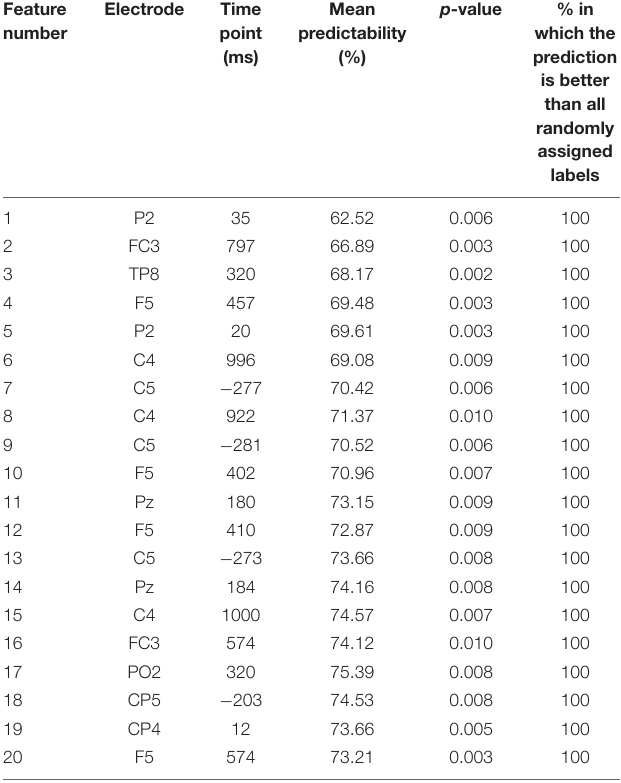
TABLE 1 | Summary of the extracted features showing feature number, electrode site, time point in ms of the extracted feature after the response was made, the mean predictability and the significance as provided from the t -tests used as a filter method in the feature selection step and the corresponding p -value for permutation